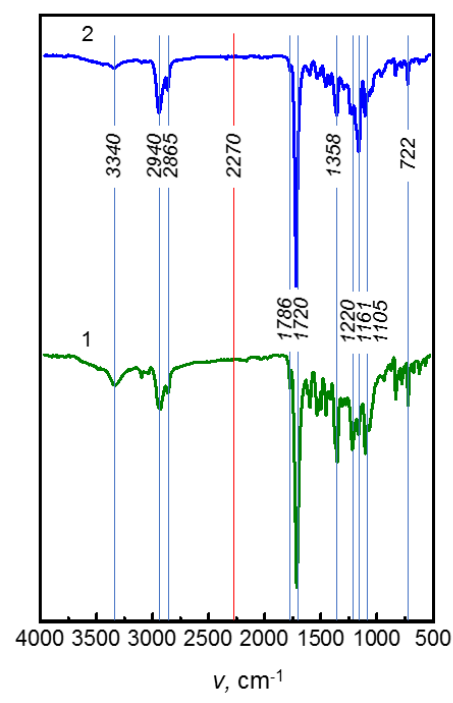
Figure 4. FTIR spectra of PUI-530 ( 1 ) and PUI-2000 ( 2 ).